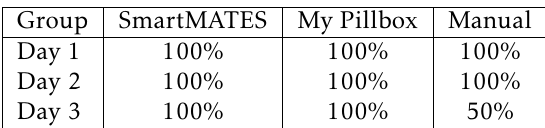
Table 2. Number of alerts Group SmartMATES My